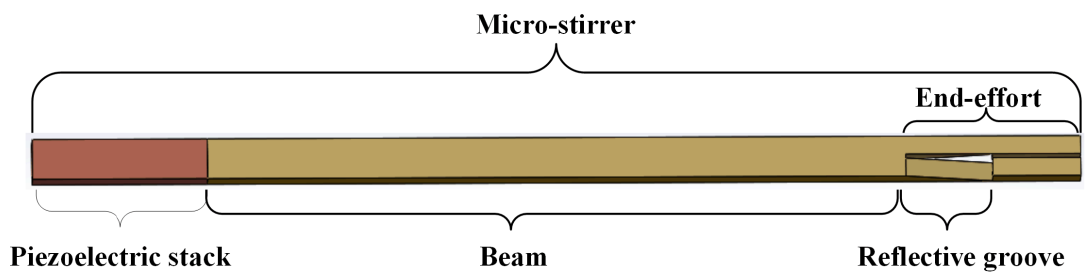
Figure 4. Schematic diagram of the scissor-type micro-stirrer. Table 1. Parameters of FEM model.